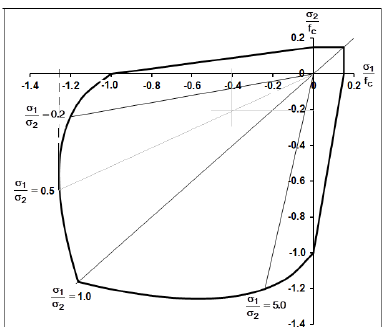
Figure 2. Ultimate Stress Envelop for concrete in biaxial state of